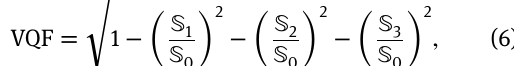
representation, all these polarisation states are mapped onto a great circle that intersects the North and South poles. Interestingly, a change in the inter-modal phase 𝛽 originates all polarisation states to rotate in the same proportion. On the Poincaré sphere representation, this is seen as a rotation of the great circle around the S 3 axis. The first row of Figure 5a, numerical simulation on top and experiment on the bottom, exemplifies this behaviour for the specific case AVW ( 𝜂, 𝜉, z = 0), with 0 , 2 𝛽 = 𝜋 ∕ 4 (purple), 𝛽 = 𝜋 ∕ 2 (green) and 𝛽 = 3 𝜋 ∕ 4 (yel- low), as representative values. In addition, a change in the weighting coefficient 𝛼 reduces the amount of right-